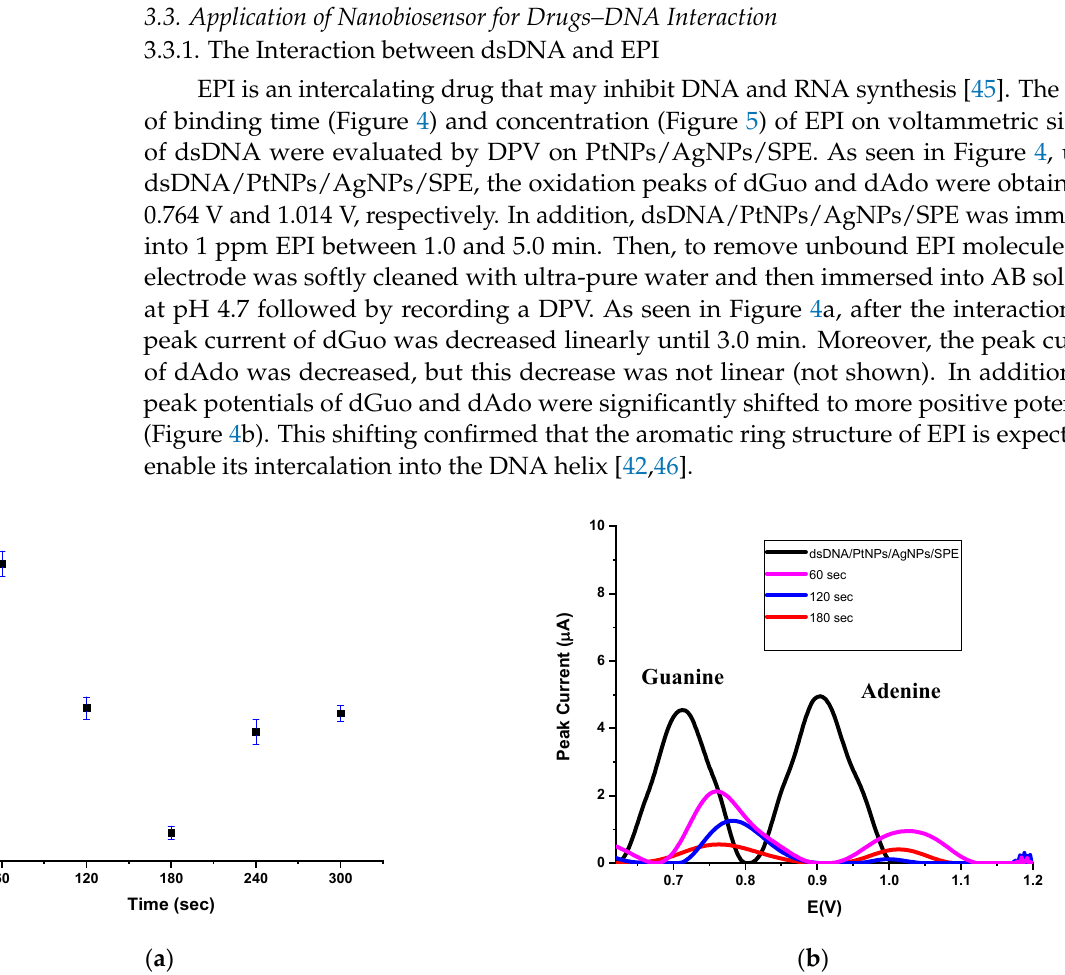
Figure 4. ( a ) The effect of binding time of 0.5 ppm EPI on the signal of dGuo; ( b ) DP voltammograms of dsDNA/PtNPs/AgNPs/SPE (black) with different binding time in pH 4.70 AB; 60 s (pink), 120 (blue), 180 s (red).